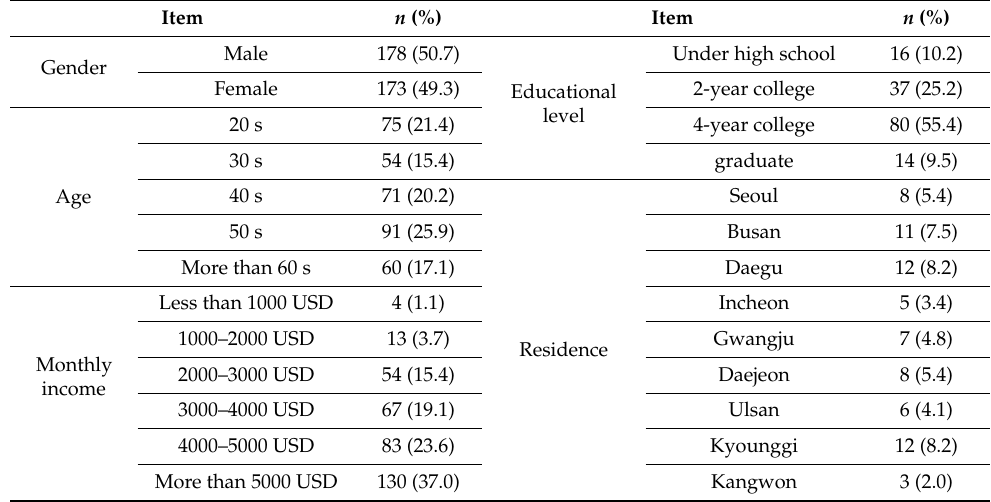
Table 1. Demographic characteristics of the